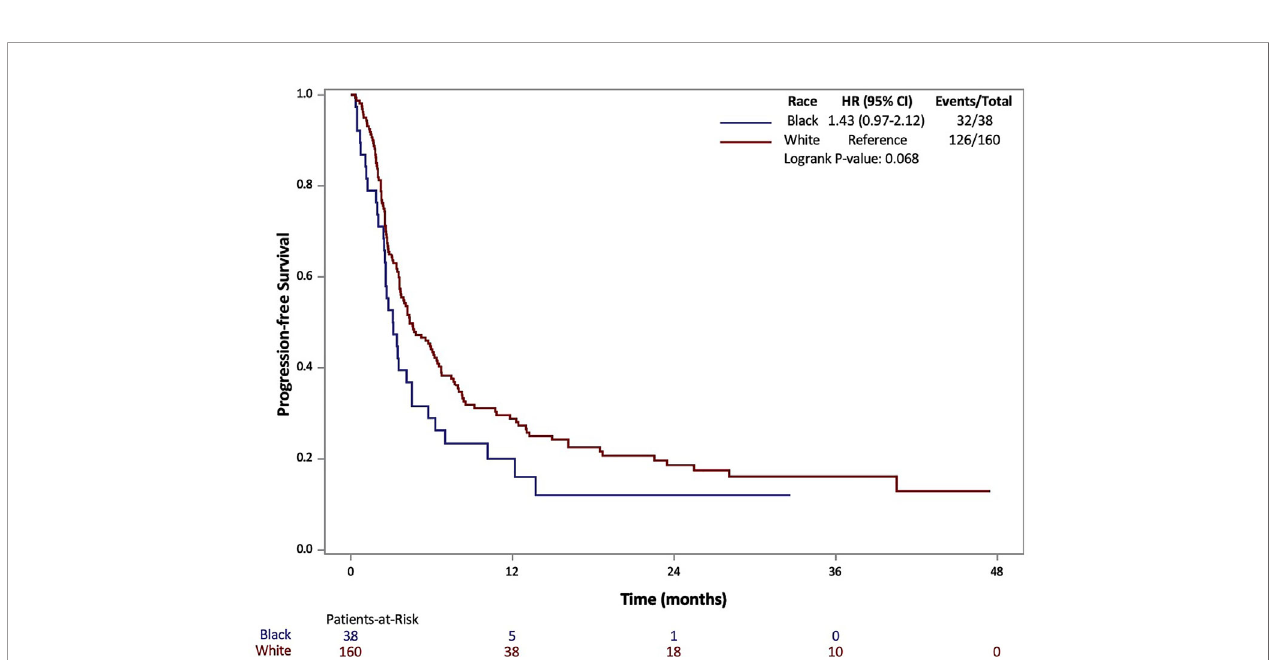
FIGURE 2 | Progression Free Survival (PFS) of patients with metastatic RCC by race: African-American (black) and Caucasian